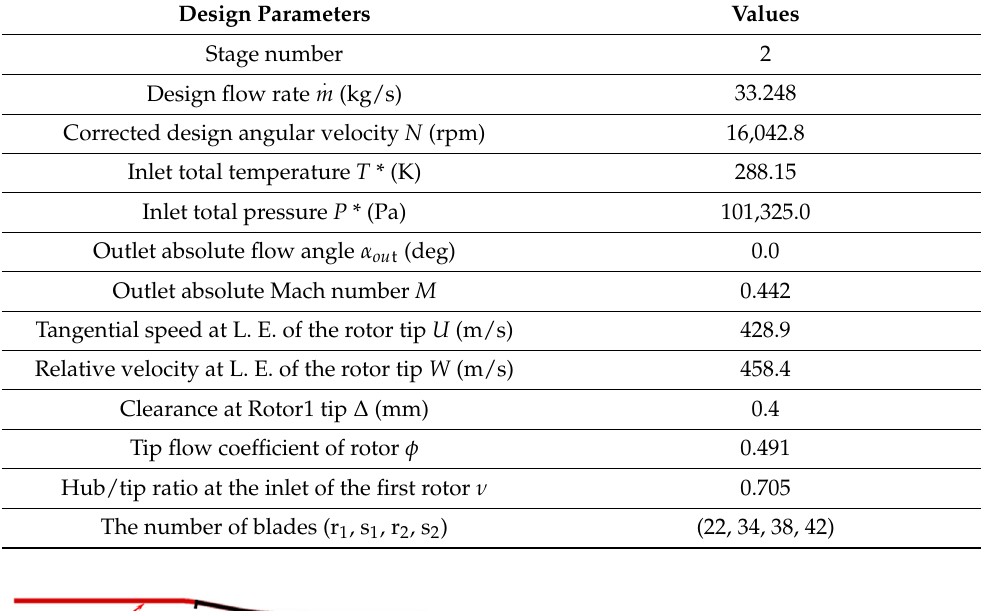
Table 1. The design data of the two-stage fan.